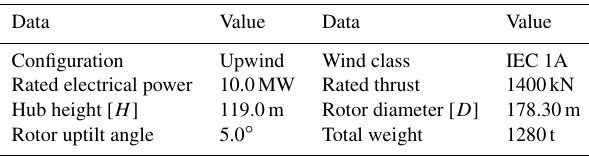
Table 1. Basic characteristics of the DTU 10MW reference wind